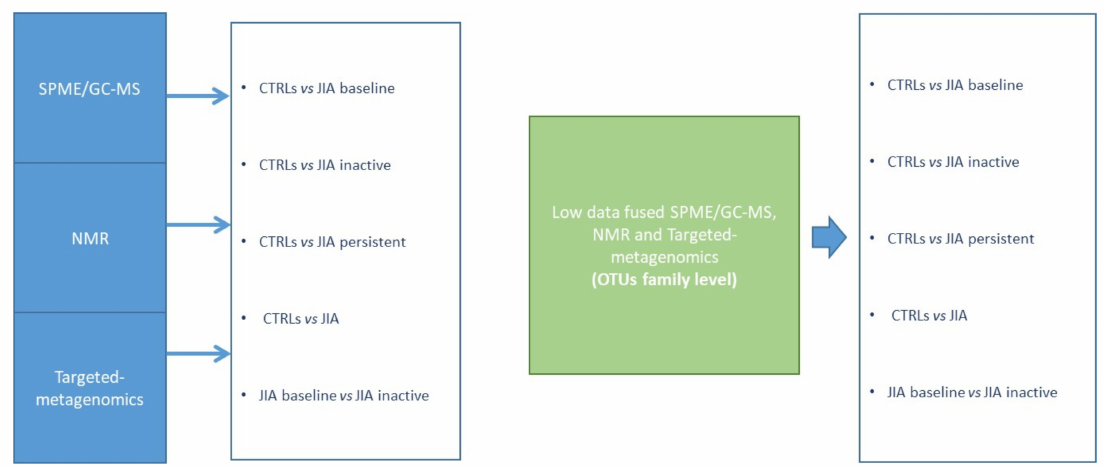
Figure 1. Strategy for the multivariate analysis of targeted-metagenomics, gas-chromatography and low data fused (integrated platforms). Classification models, based on Partial least